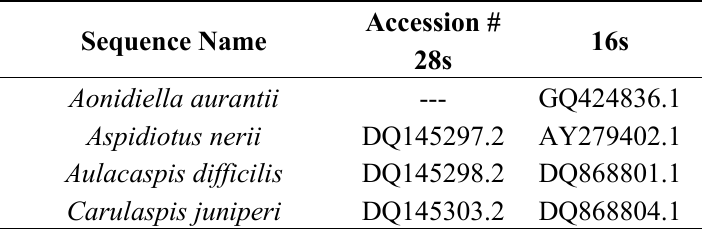
Table 2. Genbank sequences used in phylogenetic analysis. Accession numbers are provided. Dashed lines indicate a species was used in only one of the phylogenies. Double asterisks ** indicate the